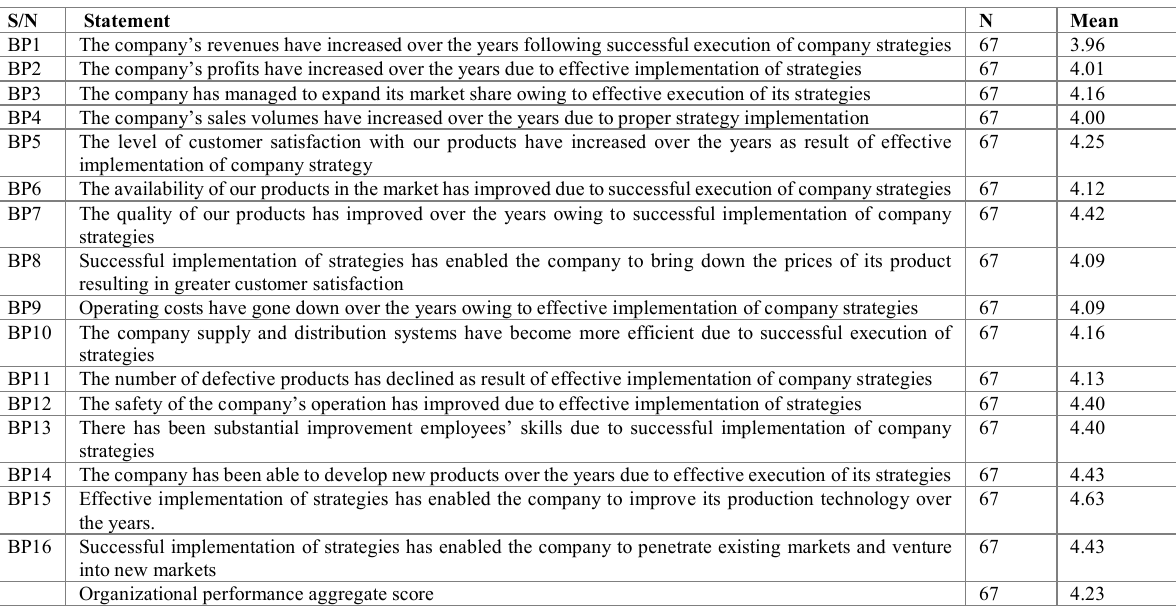
Table 4: Organizational performance at Unga Holdings